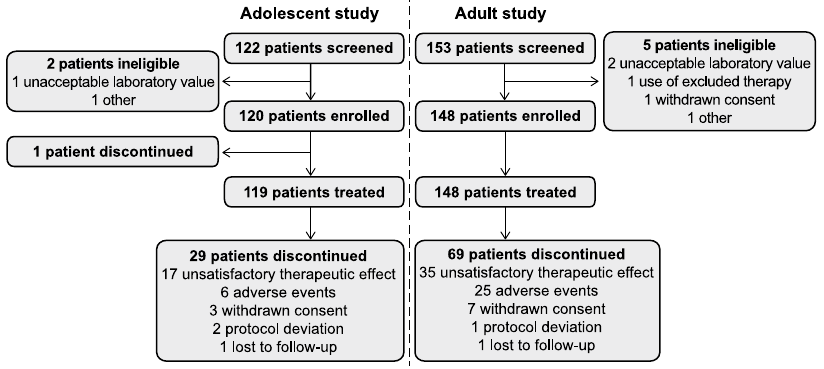
Figure 1. Patient flow * . * The discontinuations noted in this graph are those discontinuations that occurred before study termination. All patients eventually discontinued when the studies ended